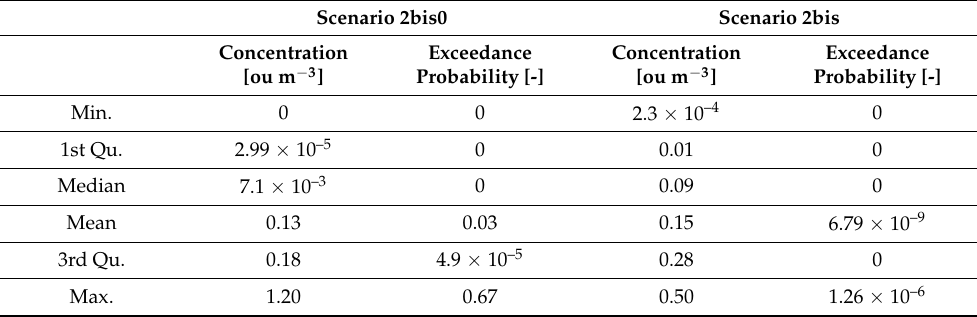
Table 5. Odour concentration and exceedance probability statistics for scenarios 2bis0 and 2bis: minimum, median, mean, 1st and 3d quartiles, maximum. Scenarios 2bis0 and 2bis are simulated for the wind gust episode